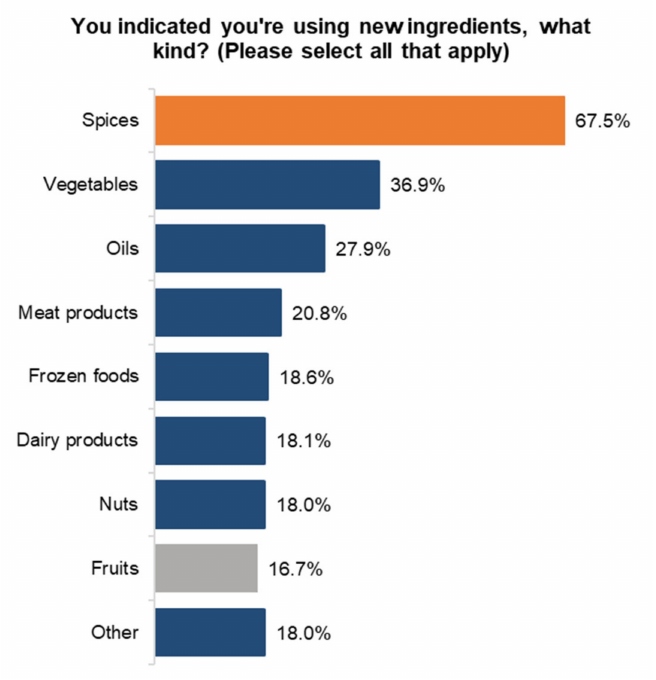
Figure 4. New ingredients used during